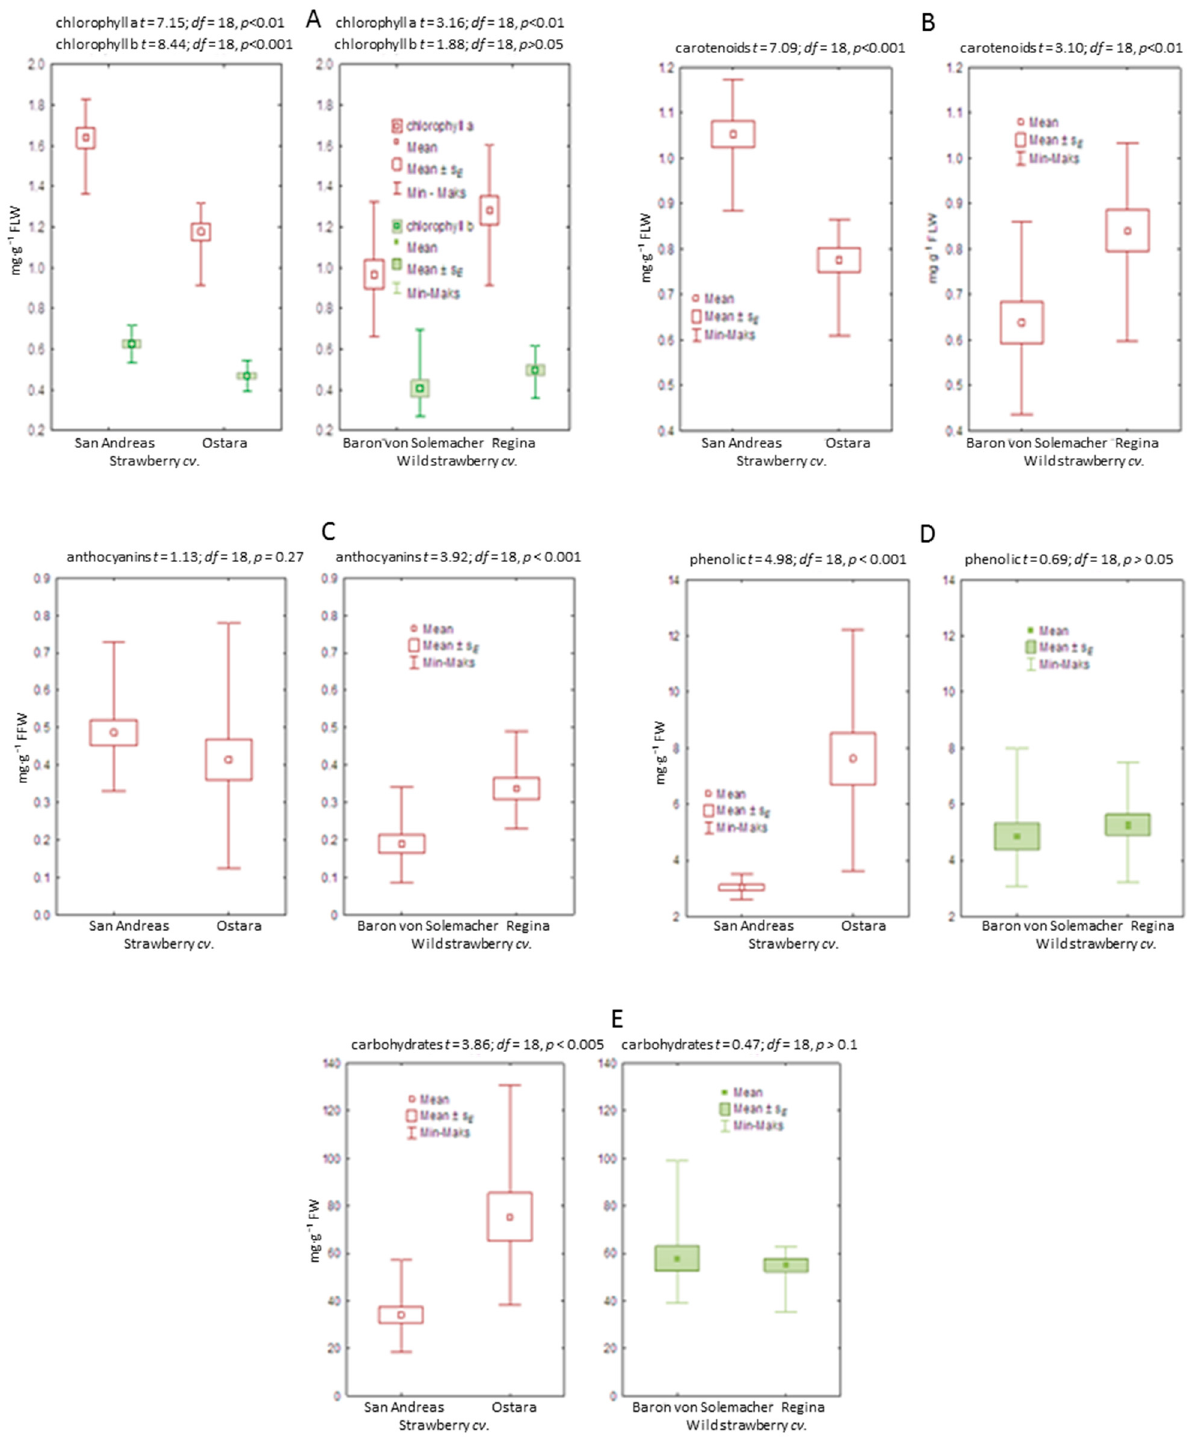
Figure 5. Box-plots of the content of chlorophylls a and b in fresh leaves ( A ), carotenoids in fresh leaves ( B ), anthocyanins in fresh fruits ( C ), phenolics in fresh fruits ( D ), and carbohydrates in fresh fruits ( E ) of strawberry and wild strawberry.